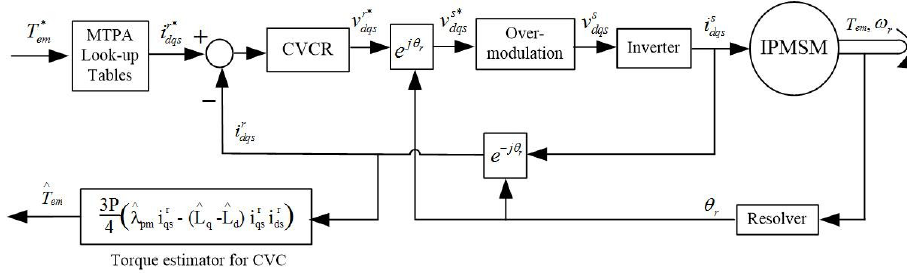
Figure 7. A block diagram of an MTPA (maximum torque per ampere) based CVC IPMSM